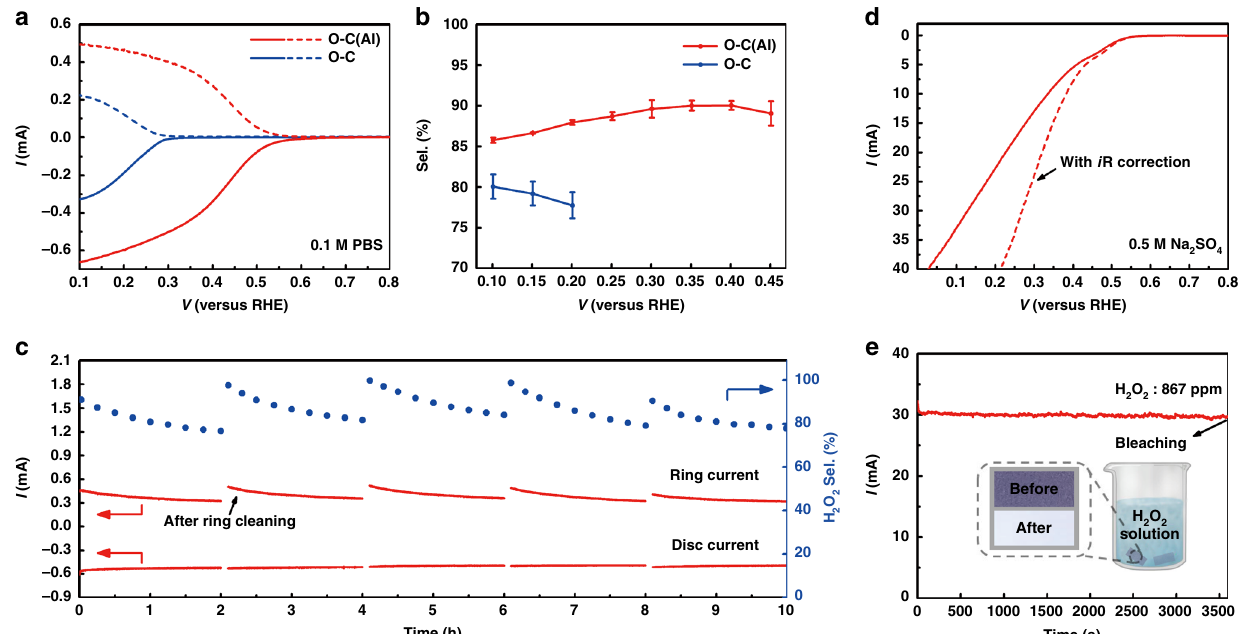
Fig. 4 ORR performance of O – C(Al) and O – C in neutral neutral electrolyte. a LSV curves of O – C(Al) and O – C (solid lines) together with the corresponding H 2 O 2 currents on the ring electrode (dashed lines) recorded at 1600 rpm in 0.1 M PBS. b Calculated H 2 O 2 selectivity at different potentials. c Stability measurement of O – C(Al) at a fi xed disk potential of ~0.2 V. The ring electrode was refreshed by rapid scan at negative potentials every two hours. d LSV of O – C(Al) catalyst in 0.5 M Na 2 SO 4 via a H-cell electrolyzer. e Bulk electrolysis at a constant current density of 30 mA cm − 2 in 0.5 M Na 2 SO 4 . Insert: the bleaching demonstration of blue litmus paper with the generated H 2 O 2 (~867